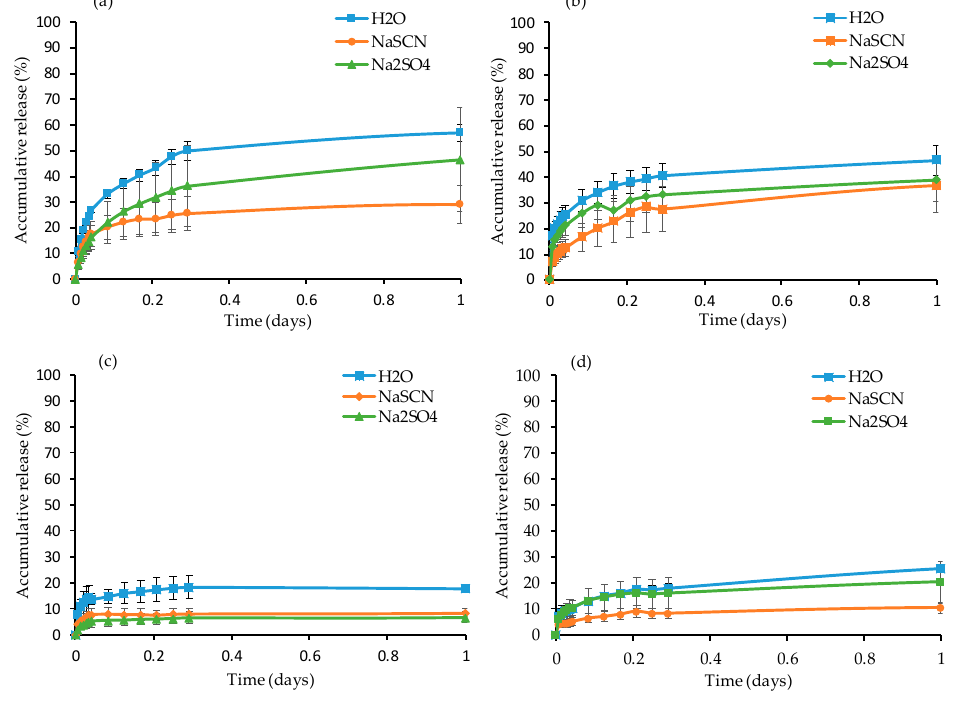
Figure 8. Accumulative release of polymer-bound fluorescein from G2R and G2F after four days in deionized water, 0.1 M NaSCN, and 0.1 M Na 2 SO 4 solutions, respectively.